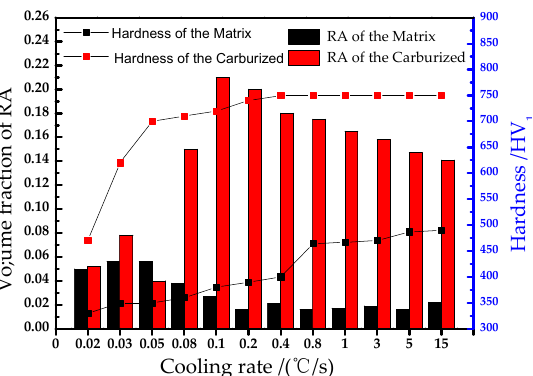
Figure 10. The volume fraction of RA and hardness of the matrix and the carburised layer.